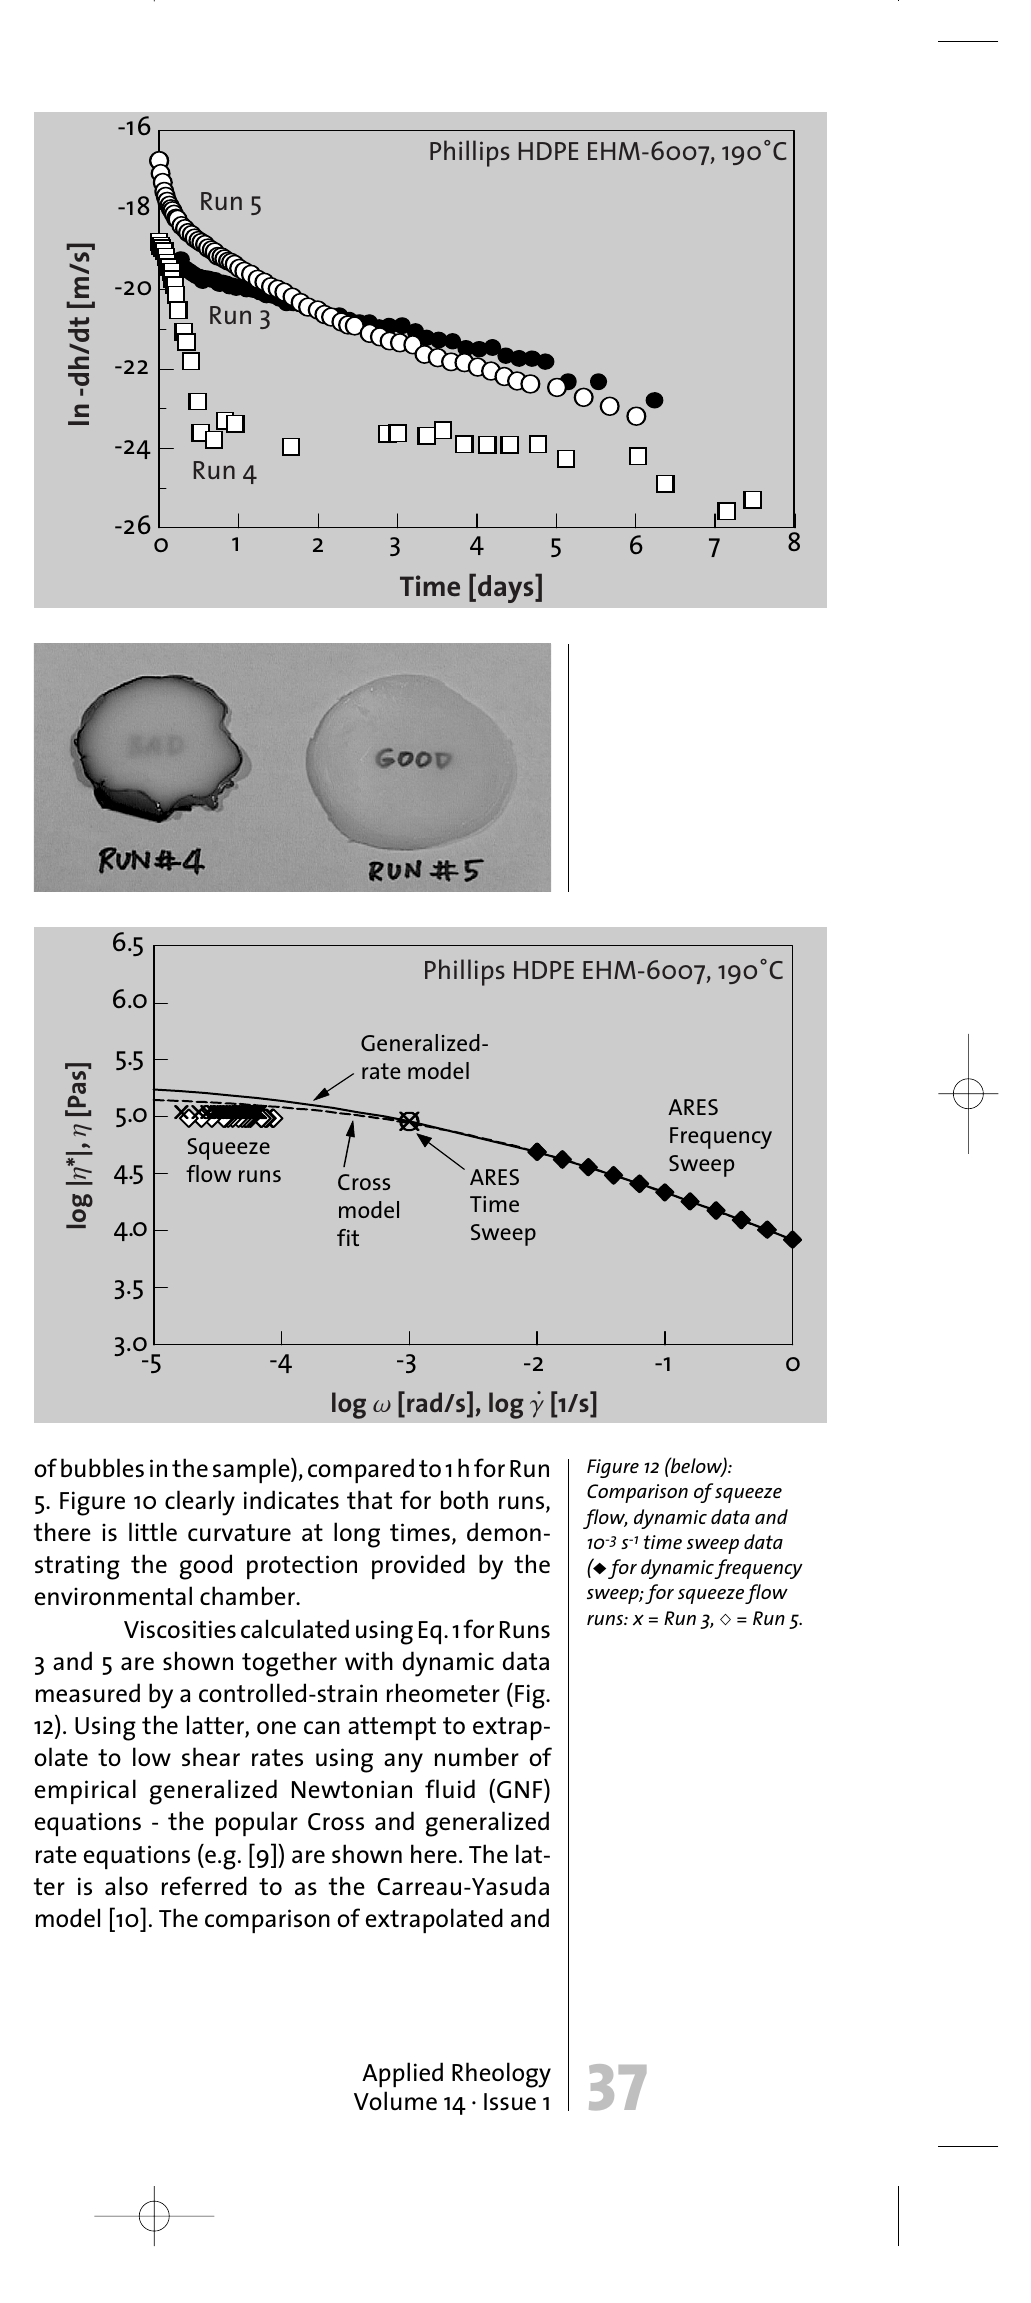
runs: x = Run 3, Ì = Run